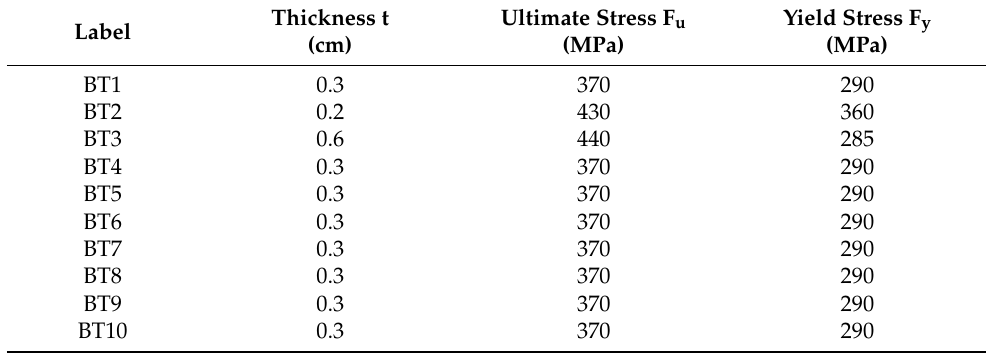
Table 1. Tensile test results of the specimens.